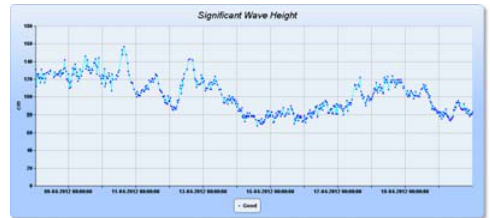
Figure 6. Time series graph of Significant Wave Height from a Wave Rider